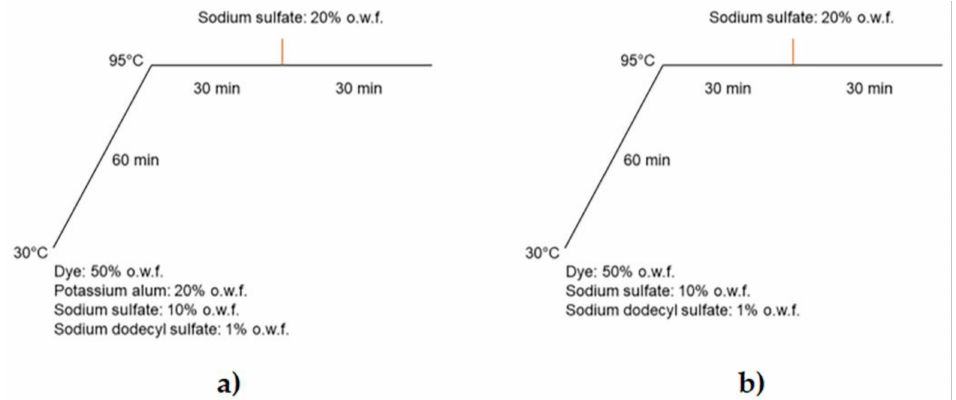
Figure 10. Protocols for the dyeing of woolen yarn with plant-derived anthocyanins at a load of 50% on weight fibers (o.w.f.) in the presence (( a ), WoolP_1) or absence (( b ), WoolP_2) of potassium alum as a mordant.